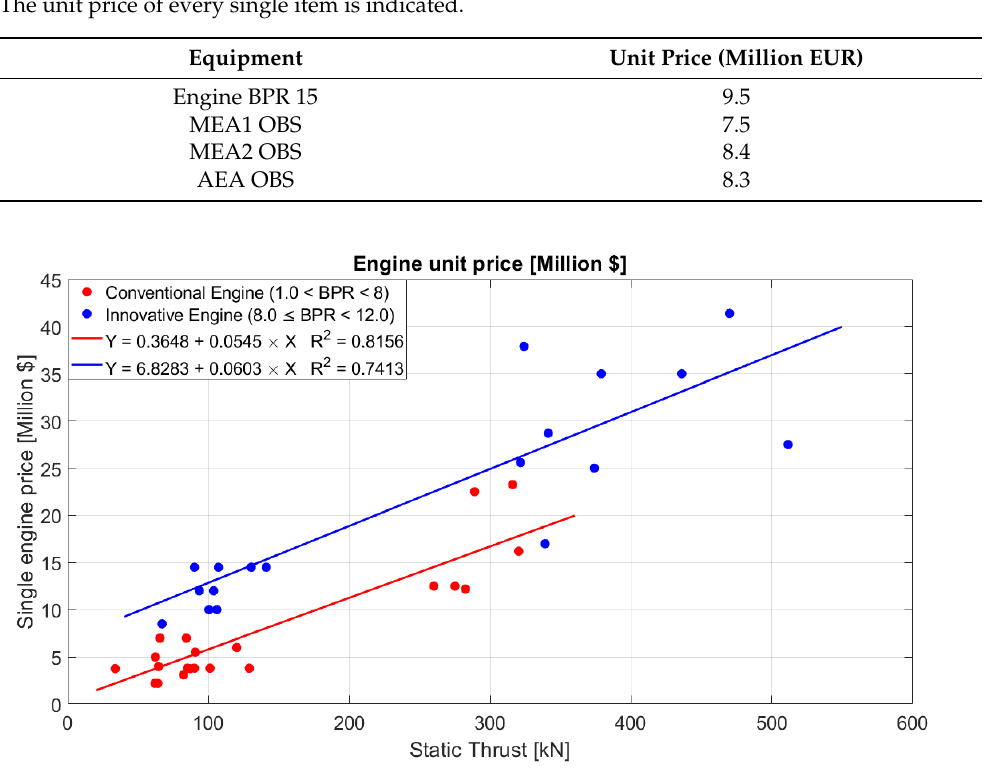
Table 10. List of the equipment considered for engine replacements and OBS electrification retrofitting. The unit price of every single item is indicated.